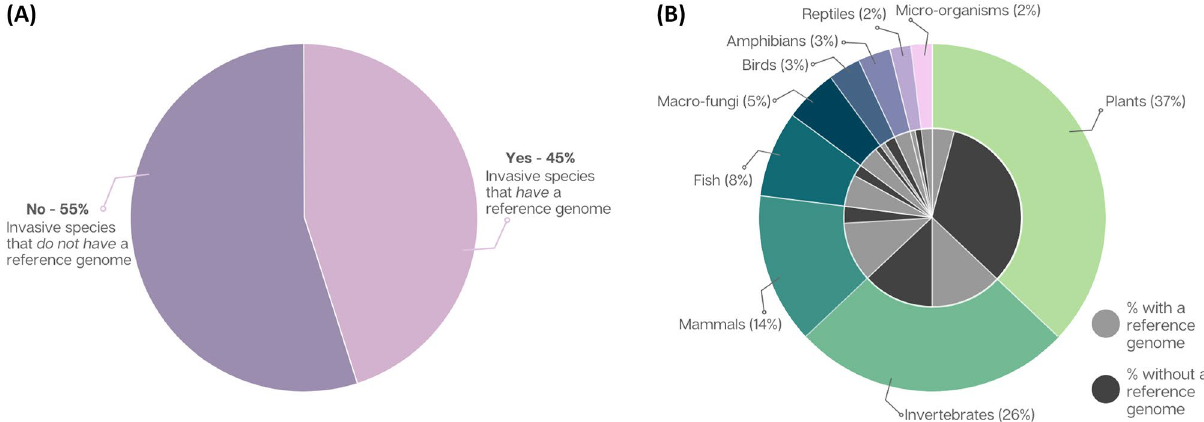
Figure 3. Proportion of invasive species from the WAS List (n = 100): ( A ) for which researchers have deposited a reference genome to NCBI; and ( B ) that correspond to the indicated taxonomic groups (outer circle), the associated proportion for which have (light grey) or lack (dark grey) reference genomes (inner